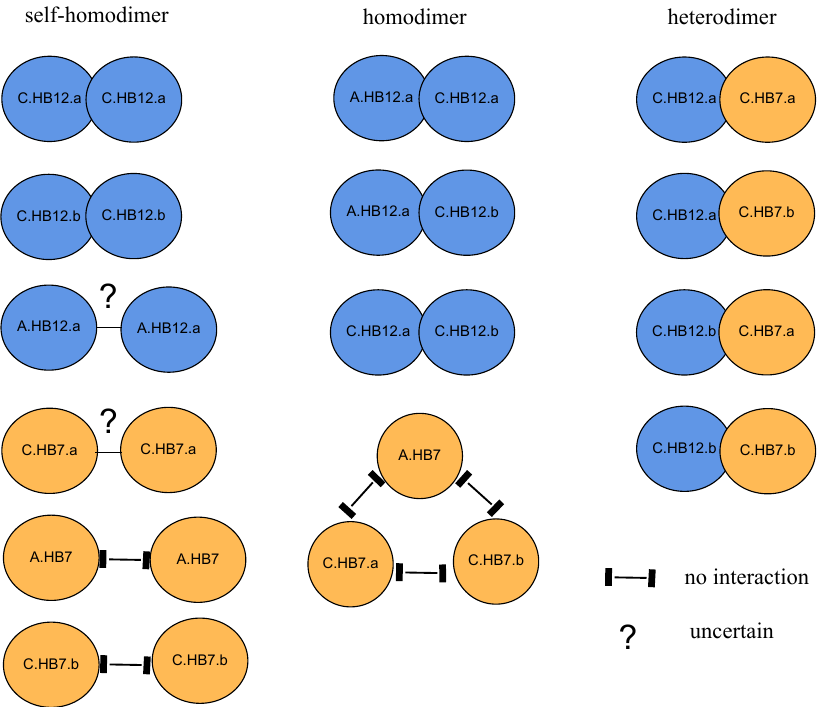
Figure 10. A summary of dimerization of BnaA.HB7, BnaC.HB7.a, BnaC.HB7.b, BnaA.HB12.a, BnaC.HB12.a, and BnaC.HB12.b in B.napus. “Bna” in the gene symbol was deleted for simplicity. Blue circles represent BnHB12 homologs and orange circles represent BnHB7 homologs. Positive control: pGBKT7-53 as prey and pGADT7-T as bait. The complex interaction pattern of homologs in B. napus may be due to the higher number of